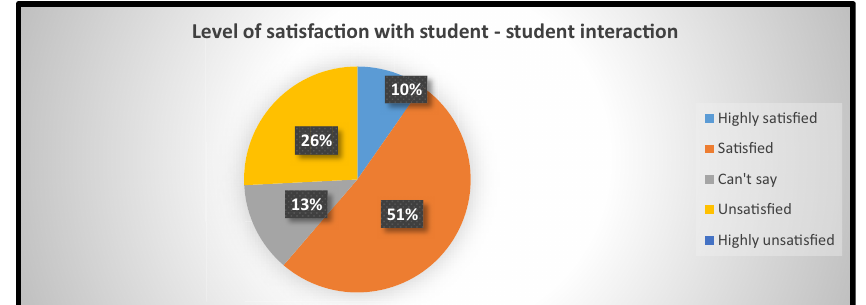
Figure 1. Level of satisfaction of students with online interactions between faculty and